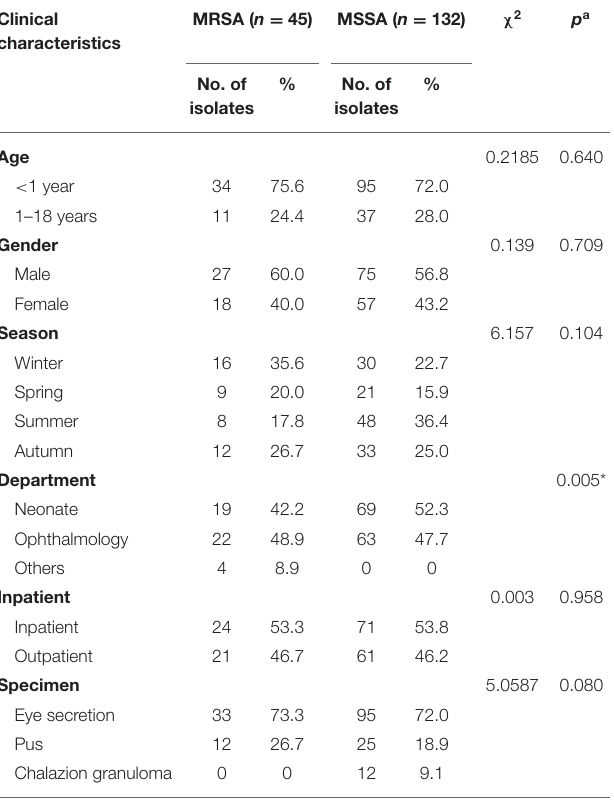
TABLE 1 | Characteristics of the study population and S. aureus isolates.